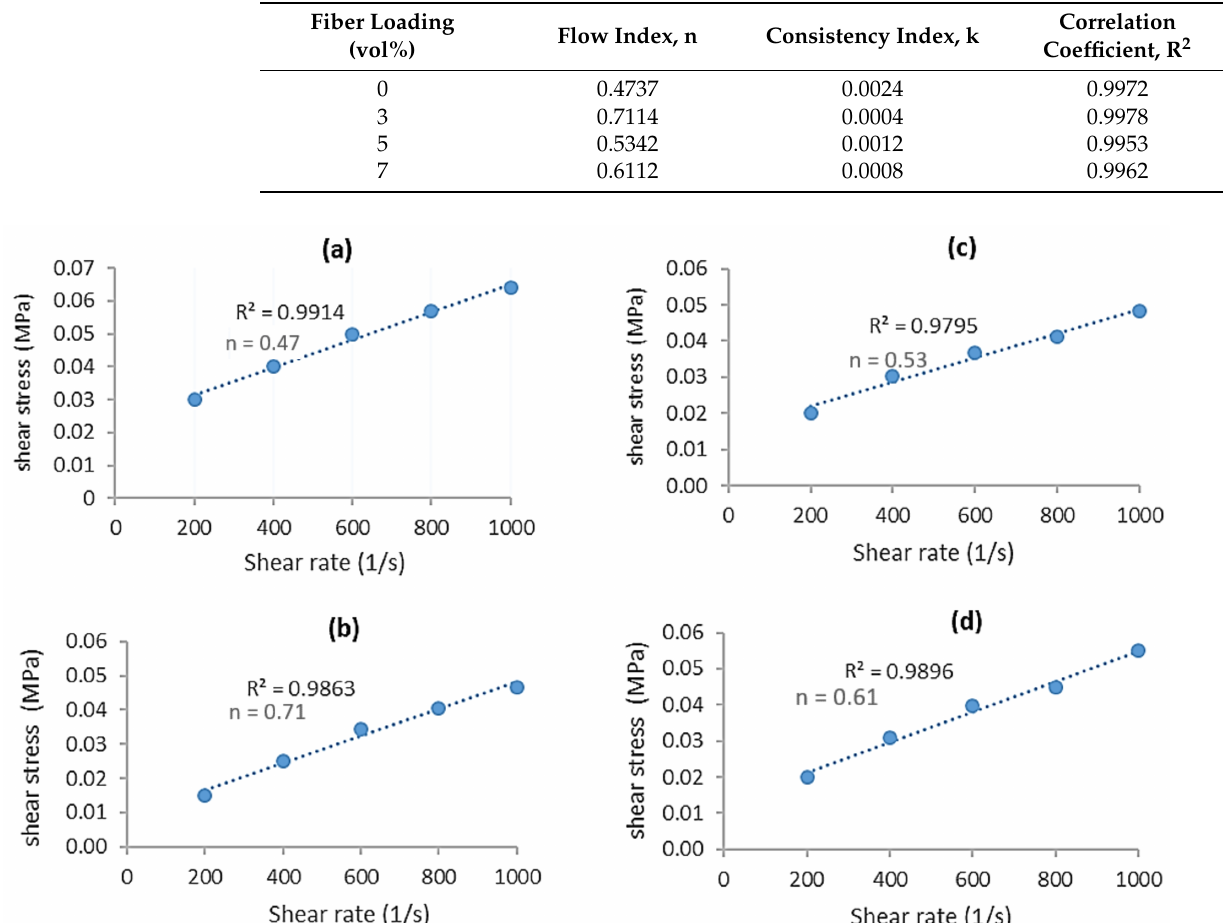
Table 2. Rheological parameter of the power law model.